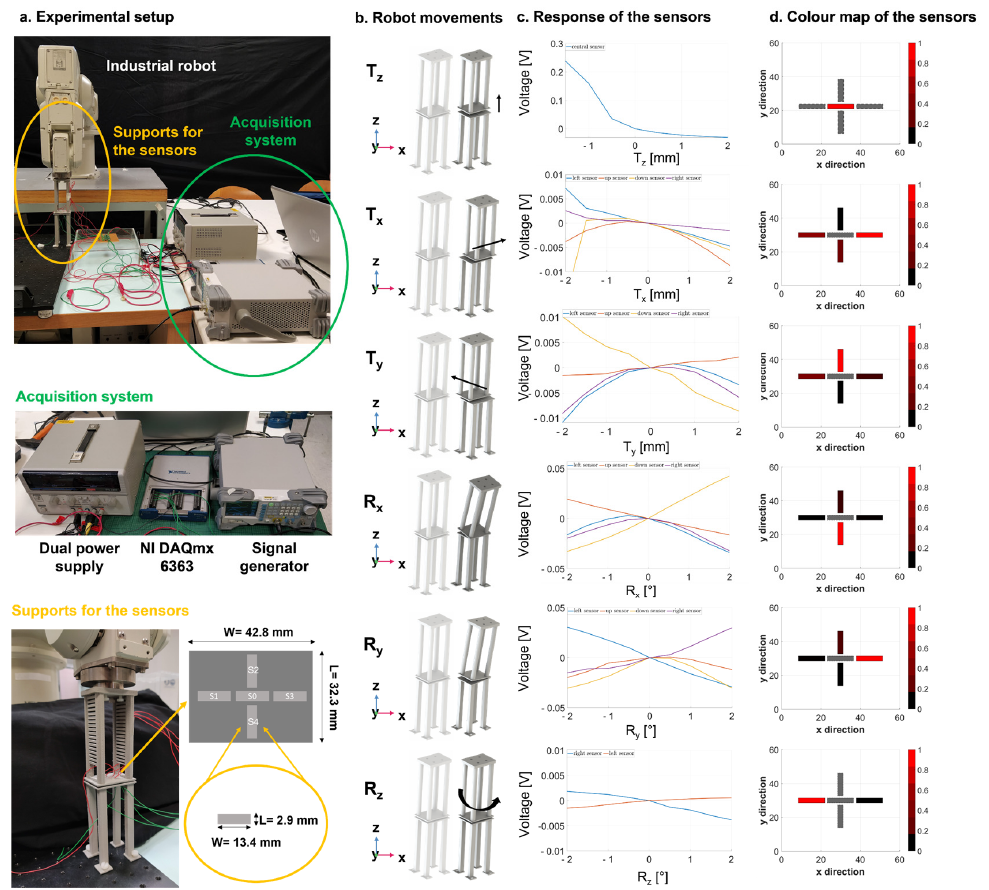
Figure 9. Characterization of the five-sensor architecture capacitive technology.